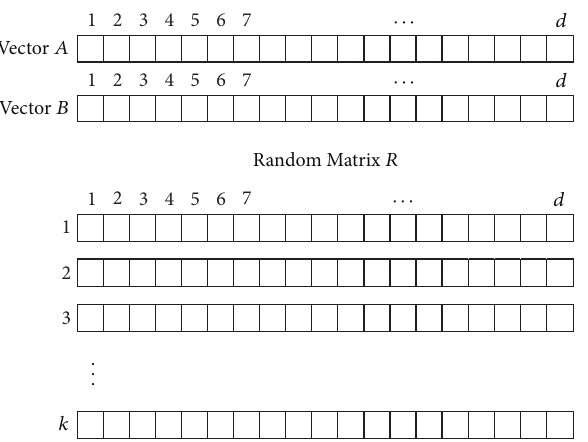
Figure 6: Sketching method on vector 𝐴 and vector 𝐵